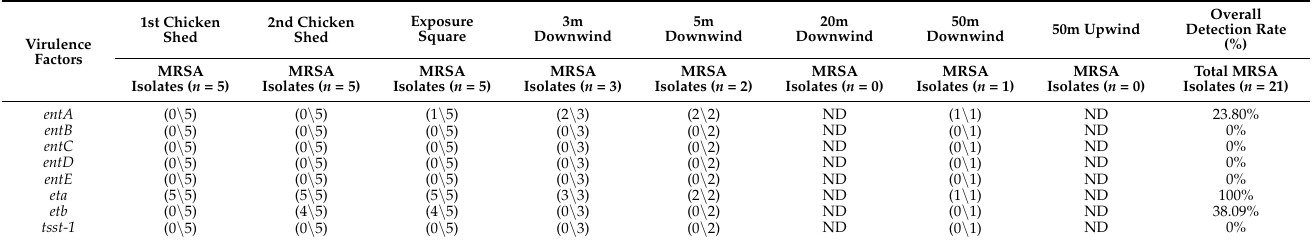
Table 3. Virulence factors profiling results of MRSA